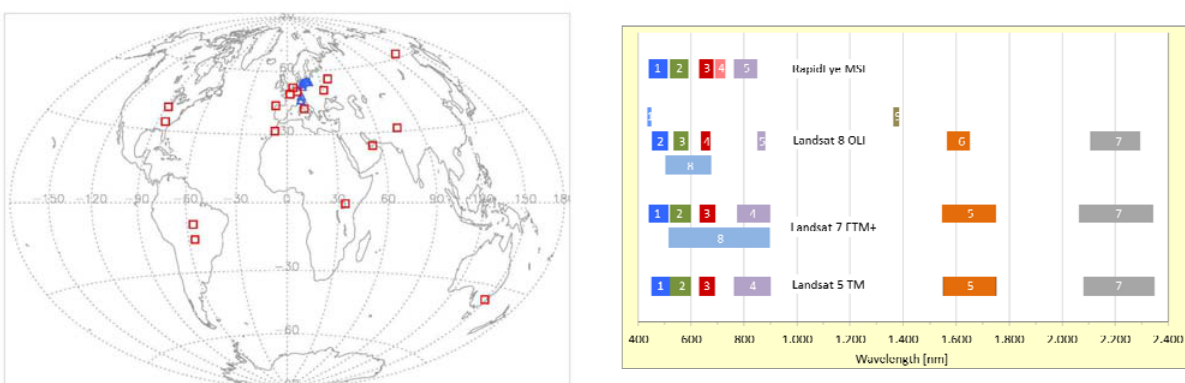
Figure 2. Spectral bands of RapidEye and Landsat